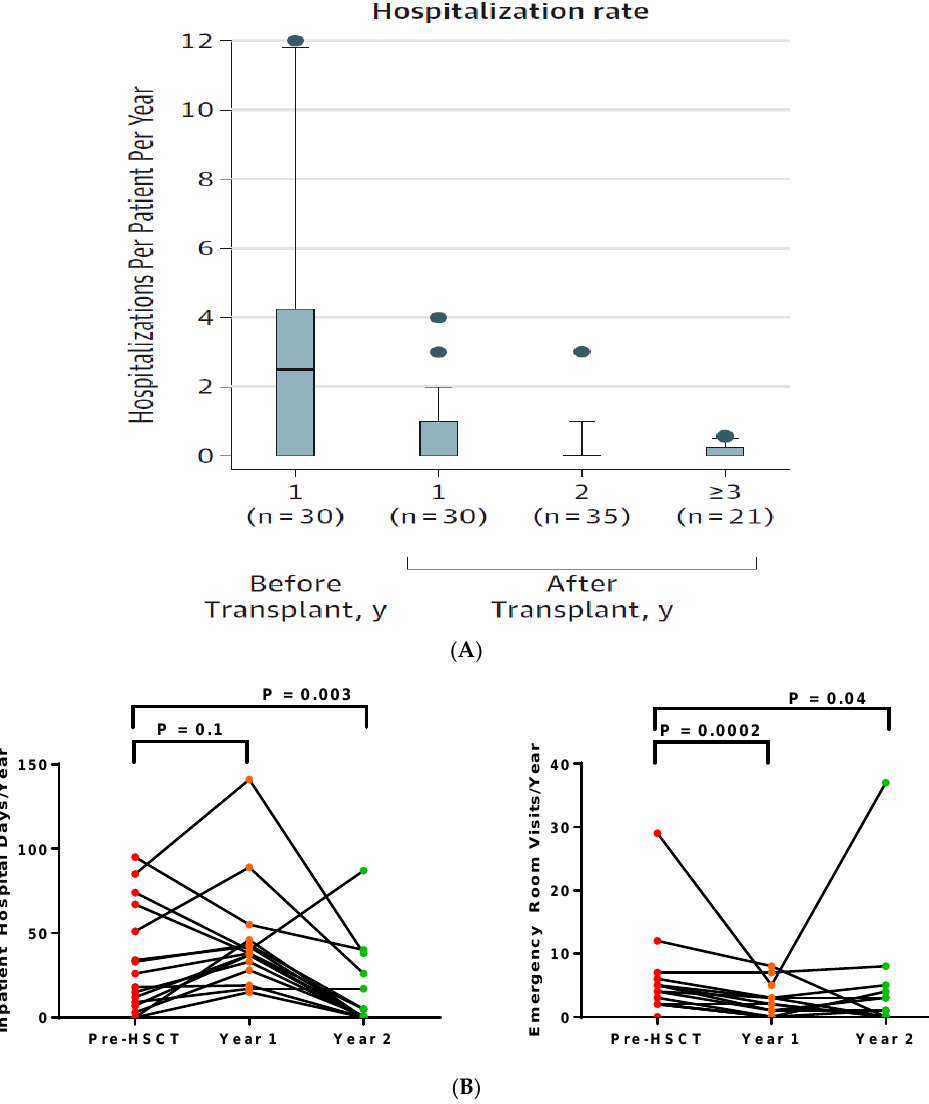
Figure 3. Lower healthcare utilization in adults with sickle cell disease after allogeneic hematopoietic stem cell transplantation from ( A ) the National Institutes of Health and ( B ) the University of Illinois at Chicago cohorts, using an alemtuzumab and total body irradiation conditioning regimen.